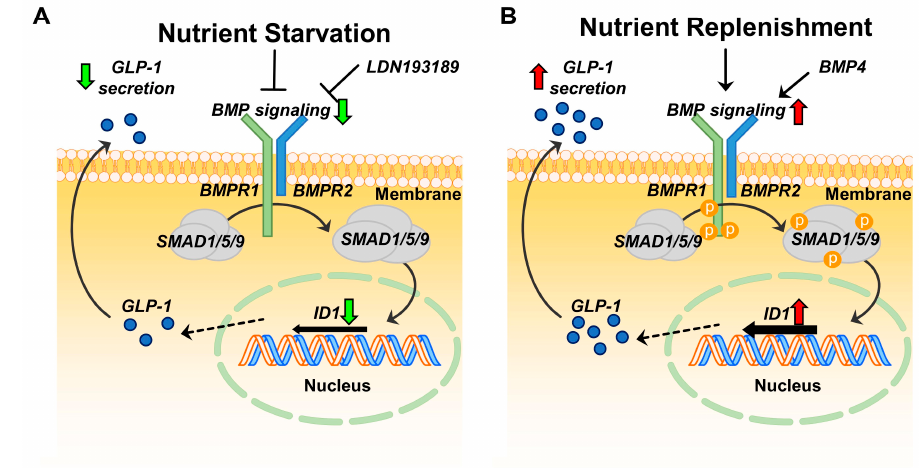
Figure 5. Molecular mechanisms of ID1-mediated BMP signaling pathway to control GLP-1 secretion in GLUTag cells. Change of nutrient status modulated ID1-mediated GLP-1 secretion in GLUTag cells. ( A ) Inhibition of BMP signaling by nutrient starvation and LDN193189 suppressed GLP-1 secretion. ( B ) Activation of BMP signaling by nutrient replenishment and BMP4 potentiated GLP-1 secretion in GLUTag cells.